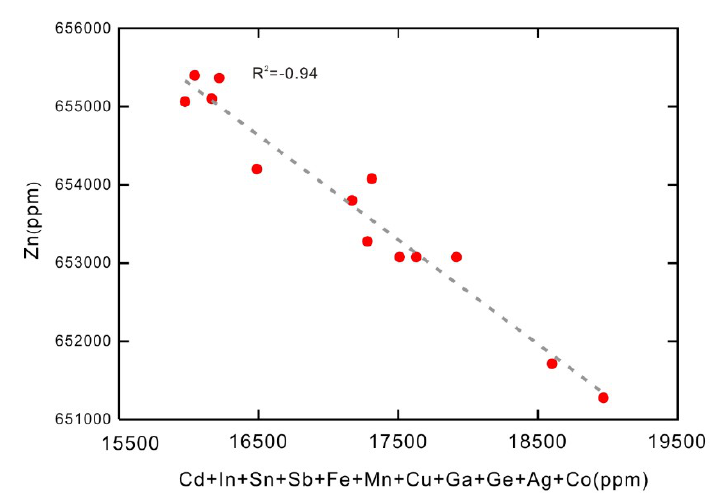
Figure 10. Correlation plots of Zn vs. (Cd + In + Sn + Sb + Fe + Mn + Cu + Ga + Ge + Ag + Co) in sphalerite from the Nayongzhi deposit. Lines of best fit and R 2 values are given. See the text for further explanation.